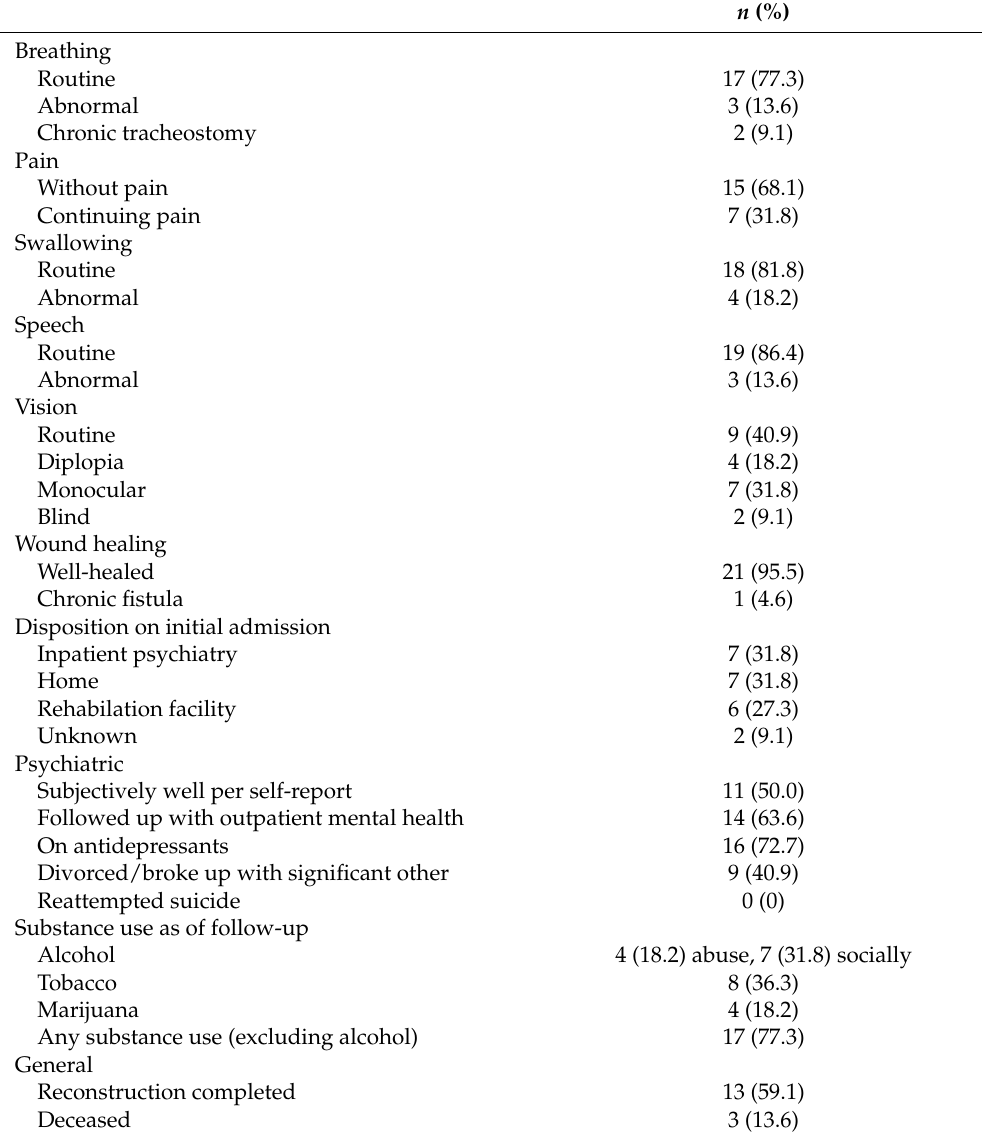
Table 6. Patient outcomes as of most recent follow-up (N =